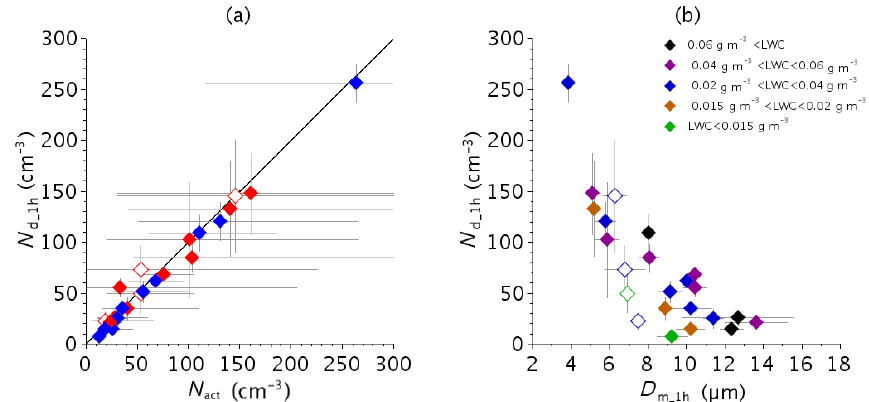
Figure 12. Droplet number concentration at the beginning of the fog for the 23 cases as a function of (a) the activated particle concentration ( N act ) and (b) the mean fog diameter. Diamonds correspond to median values and error bars to 25th–75th percentile intervals. Symbol colors are as a function of (a) fog type as in Fig. 2 and (b) LWC values as indicated in the legend.